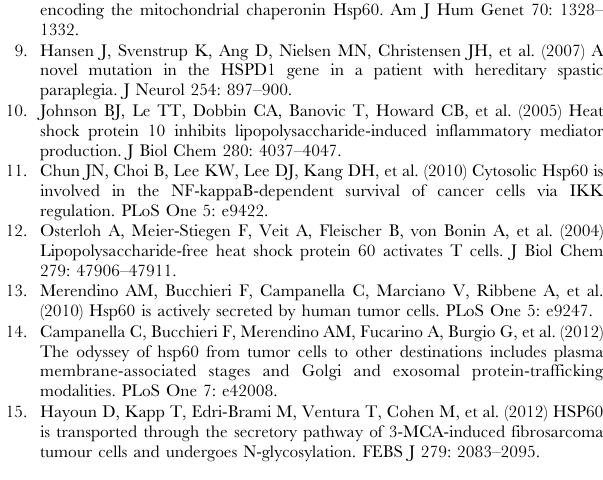
Figure S2 SDS-PAGE of the various purified proteins used in this study. 10 m g of each protein was separated by 14% SDS-PAGE and stained with Coomassie blue. (DOC) Figure S3 The highly conserved salt bridge between positions 321/322 and 176/178. A multiple sequence alignment of various mitochondrial and bacterial chaperonin sequences was produced using the ClustalW2 program. Only the amino acids corresponding to positions 322 and 178 in GroEL or 176 and 321 in mHsp60 are presented. Residues displaying a different charge than their counterparts in a particular position are presented with a gray background. (DOC) Figure S4 Tyrosine 360 in GroEL interacts with a hydrophobic cluster of the adjacent subunit. A three dimensional model showing a side view of a GroEL ring in the closed state. Each subunit is colored differently (left image). Y360, a neighbor of D359, interacts with the A383-L183-F281 cluster in which A383 and L183 are located on the adjacent subunit (PDB entry 1AON). Image was created using the PyMOL program. Figure S5 Multiple sequence alignment of various mitochondrial and bacterial chaperonin sequences. Only the amino acids corresponding to positions 80 and 359 in GroEL or 70, 78, 81, 82 and 358 in mHsp60 are highlighted. Residues having a different charge from their counterparts in a particular position are presented with red letters. Produced by the ClustalW2